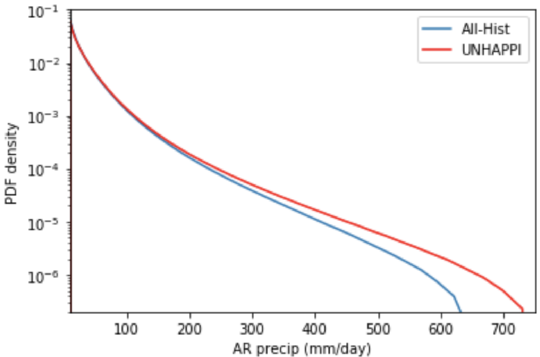
Figure 10. Conditional PDF for atmospheric river precipitation computed using fastKDE (O’Brien et al., 2016).